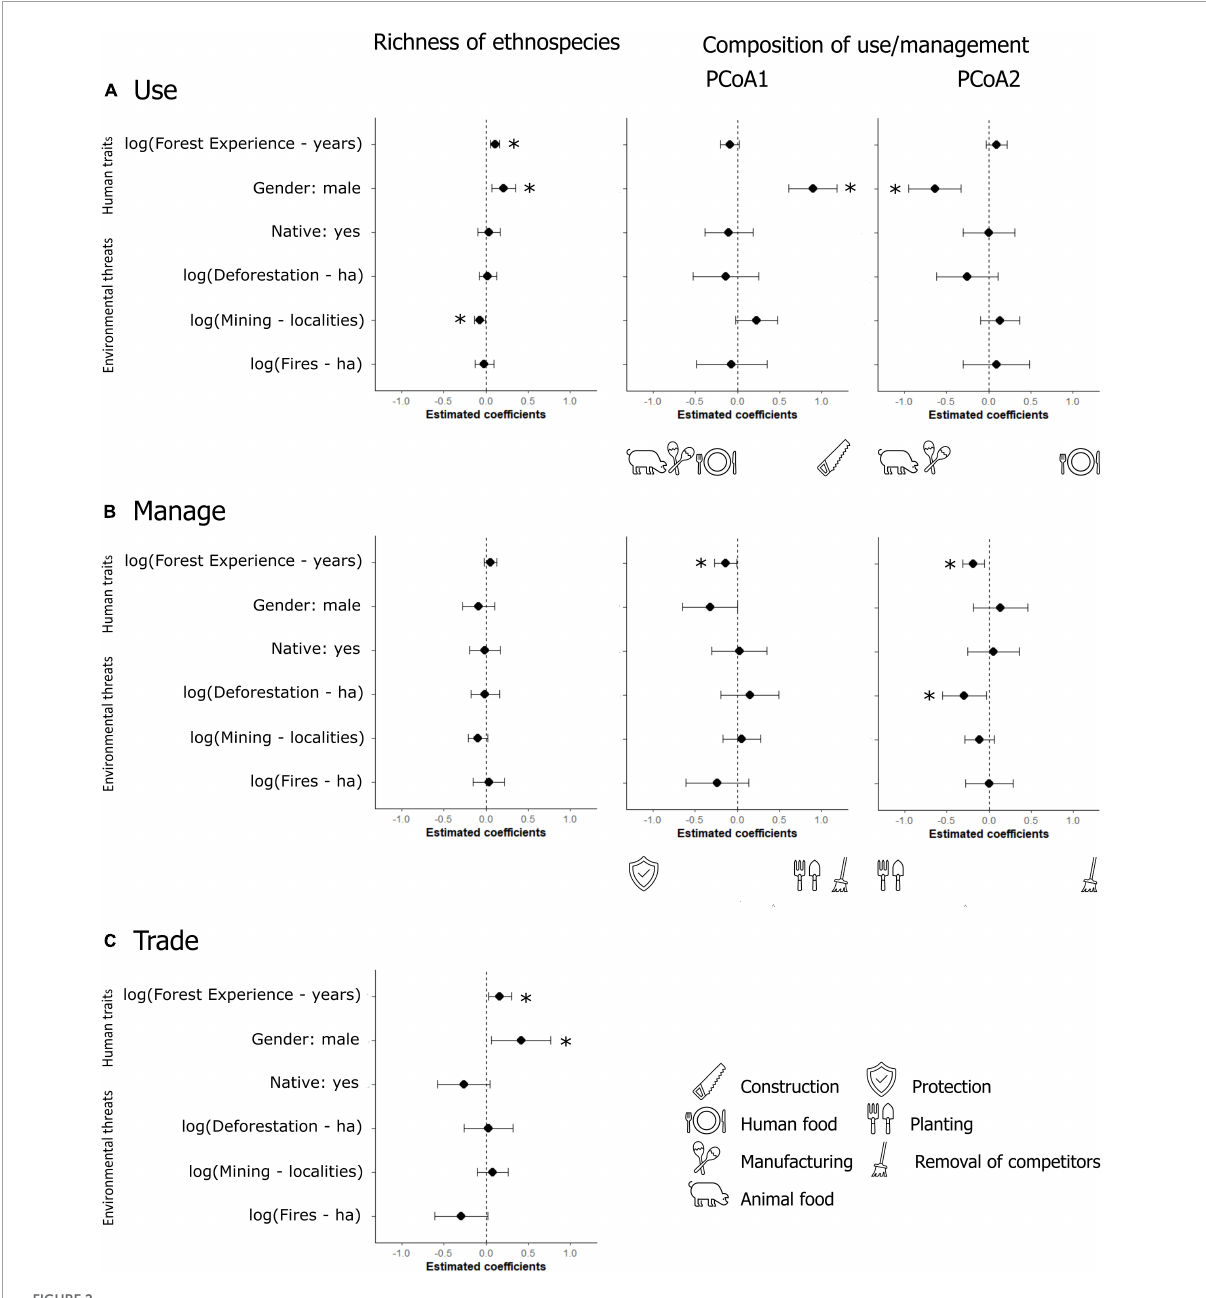
FIGURE2 Relationships among ethnospecies richness and composition of use and management categories, and forest specialists’ characteristics (forest experience, gender, and origin) and environmental threats (deforestation, mining, and fires). The standardized beta coefficients and 95% confidence intervals of explanatory variables of generalized linear mixed-effects models are shown for: (A) used ethnospecies richness ( R 2 = 0.20; p < 0.001) and composition of use categories (PCoA1, R 2 = 0.48, p < 0.001 and PCoA2, R 2 = 0.35, p < 0.001); (B) managed ethnospecies richness ( R 2 = 0.21, p = 0.014) and composition of management categories (PCoA1, R 2 = 0.26, p < 0.001 and PCoA2, R 2 = 0.25, p < 0.001); (C) traded ethnospecies richness ( R 2 = 0.27, p < 0.001). The composition of use and management categories are expressed by